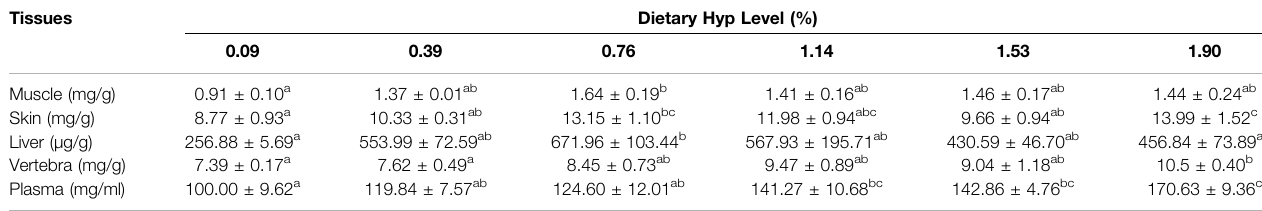
TABLE 8 | The hydroxyproline content in different tissues of ITCC fed with different experimental diets for 8 weeks. Tissues